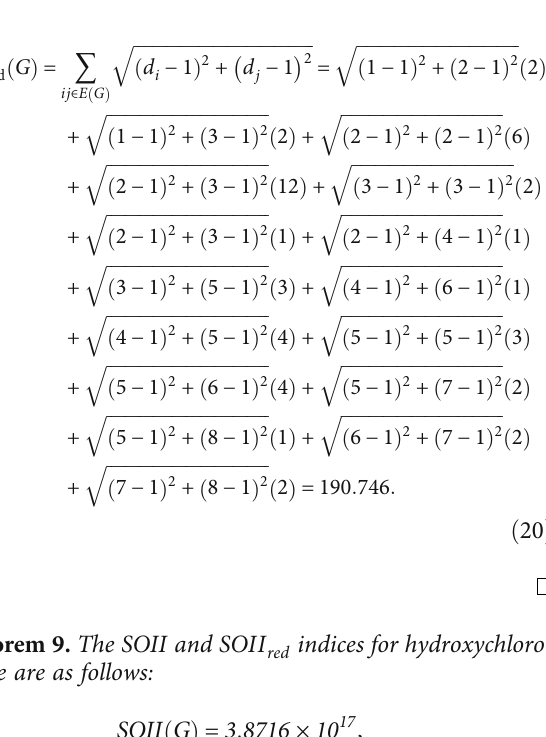
ffiffiffiffiffiffiffiffiffiffiffiffiffiffi p 2 ð Þ × 1 2 + 3 2 ffiffiffiffiffiffiffiffiffiffiffiffiffiffi p 12 ð Þ × 3 2 + 3 2 ffiffiffiffiffiffiffiffiffiffiffiffiffiffi p 1 ð Þ × 3 2 + 5 2 ffiffiffiffiffiffiffiffiffiffiffiffiffiffi p 4 ð Þ × 5 2 + 5 2 p ffiffiffiffiffiffiffiffiffiffiffiffiffiffi 2 ð Þ × 5 2 + 8 2 2 ð Þ = 3 : 8716 × 10 17 ,